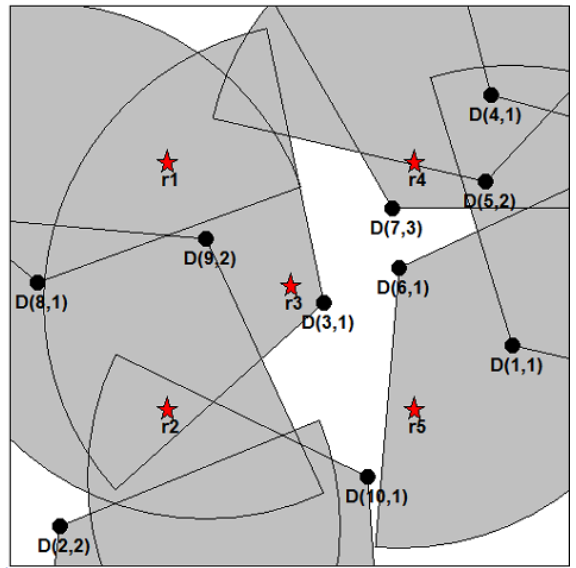
Figure 5. An example of target and sensor deployment.